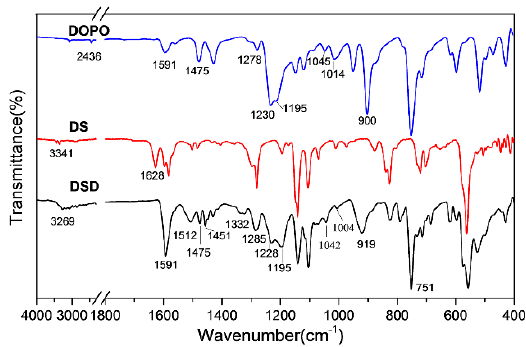
Figure 1. FTIR spectra of DOPO, DS, and DSD.